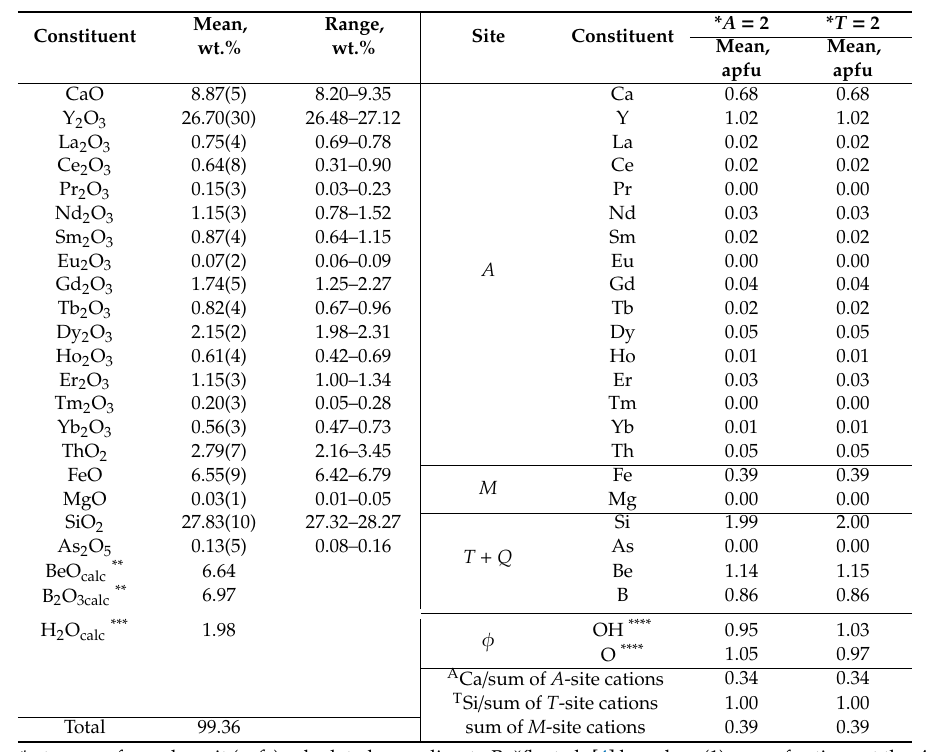
Table 1. Elemental composition (WDX) and coe ffi cients in the formula of hingganite-(Y) from the Wanni glacier, Switzerland.